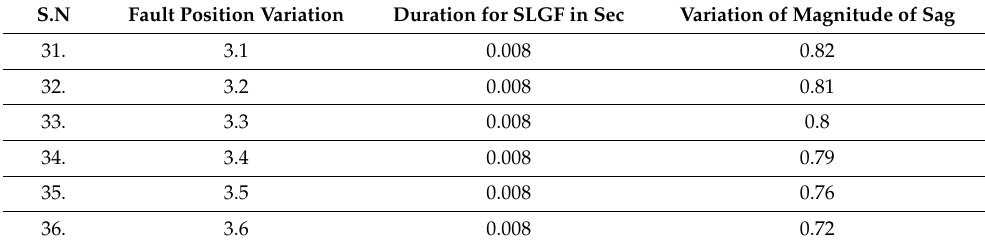
Table 3. Fault rate of the lines and buses.